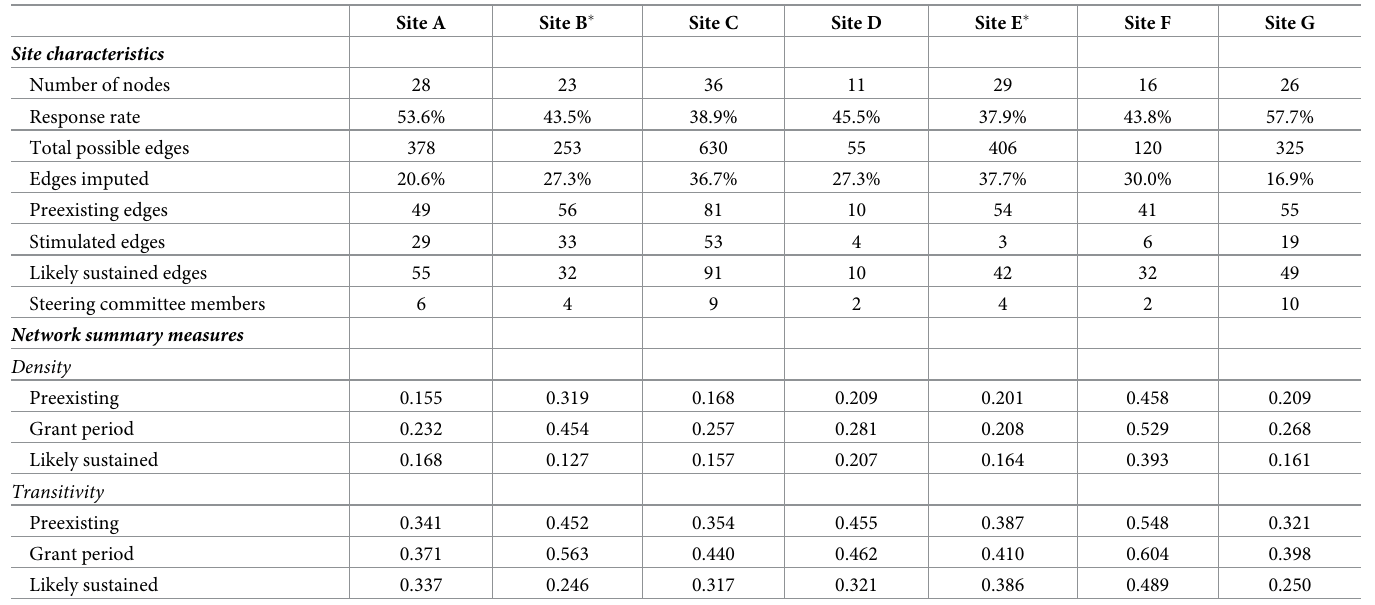
Table 1. Iowa ACH site characteristics and network summaries.